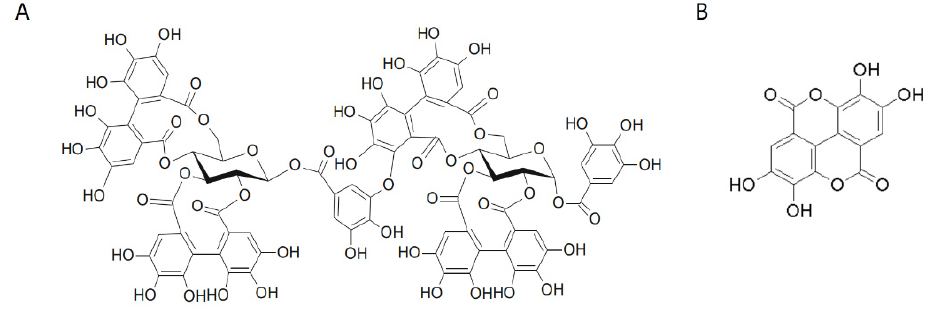
Figure 1. The chemical structure of sanguiin H-6 ( A ) and ellagic acid ( B ).